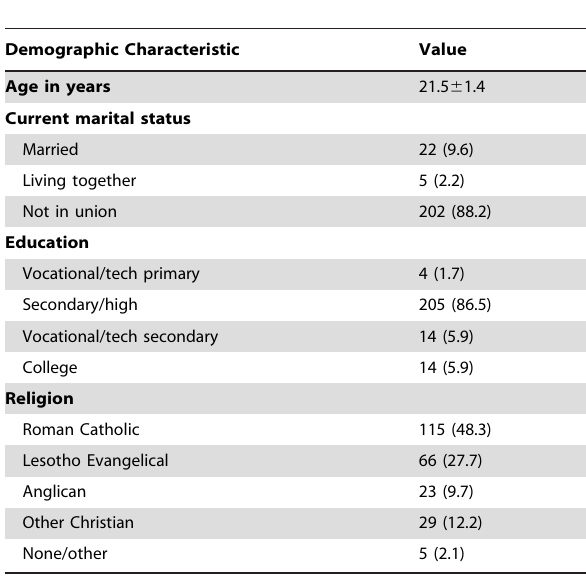
Table 2. Demographic characteristics of study participants ( n